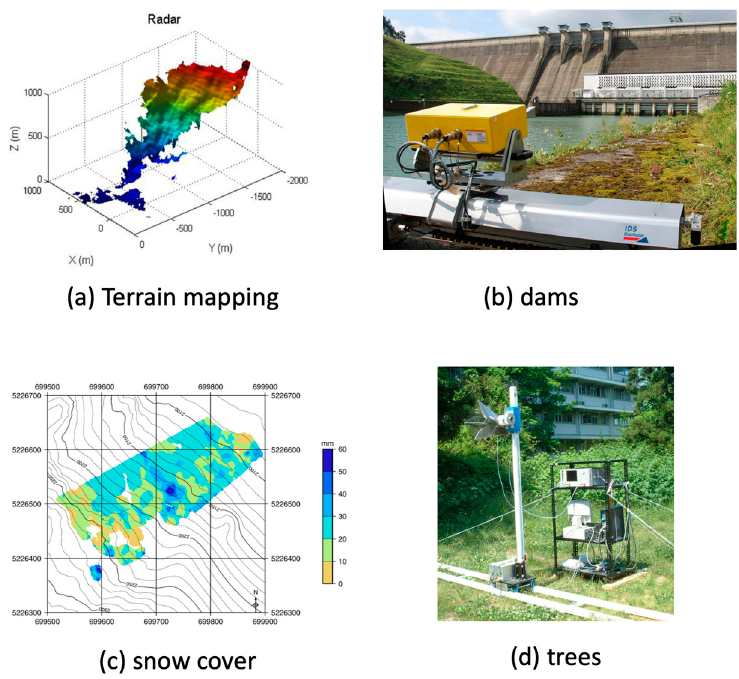
Figure 11. Examples of GBRI applications: ( a ) terrain mapping, digital elevation model of a slope obtained through GBSAR (after [84]) ( b ) dams monitoring (courtesy of IDS georadar [48]); ( c ) snow cover monitoring, map of snow water equivalent change obtained by GBSAR (after [85]); ( d ) trees monitoring by GBSAR (after [86]).